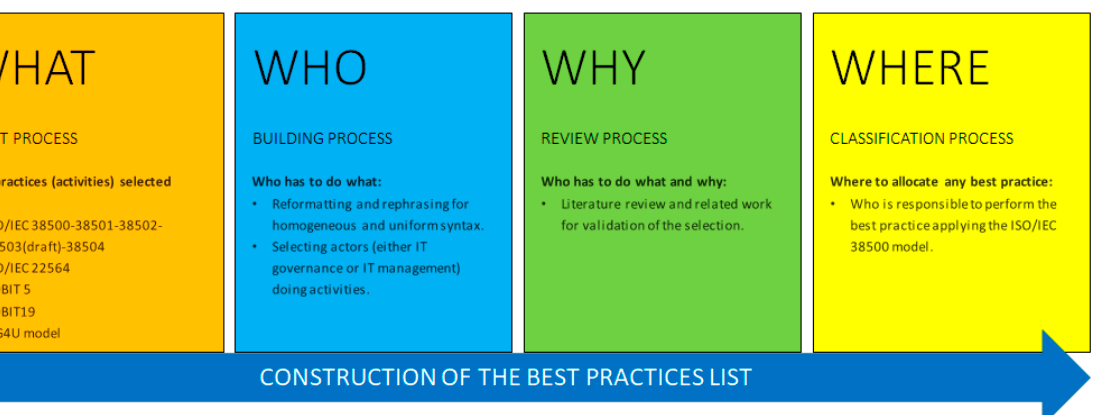
Figure 3. Model of classification of best practices allocation.